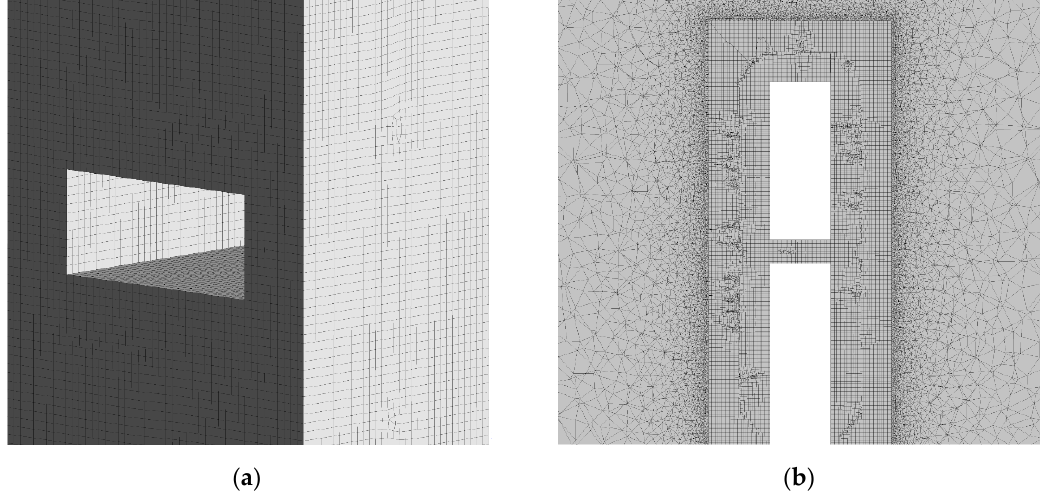
Figure 5. Computational mesh around the surfaces of the skygarden model ( a ) at the building face and ( b ) along the central plane.